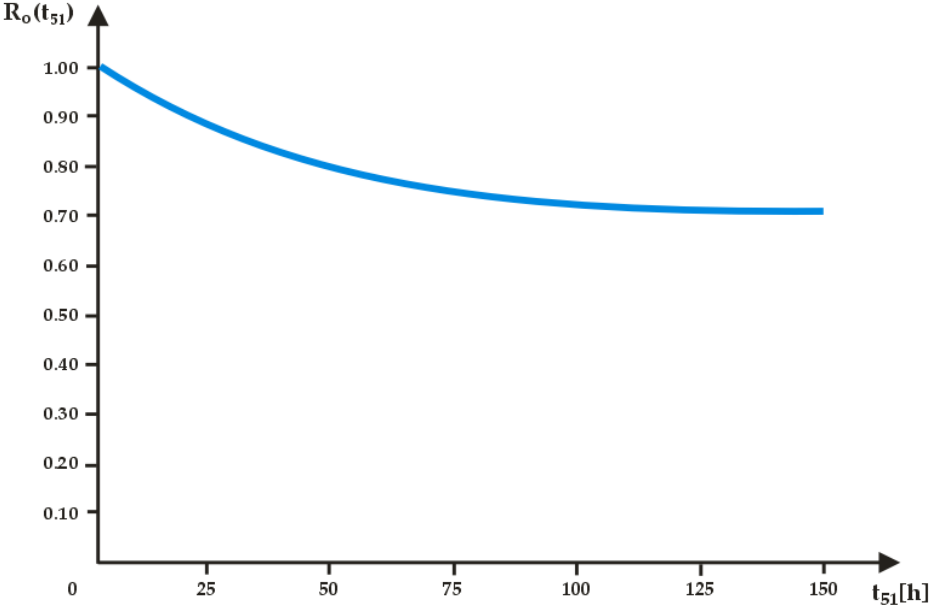
Figure 5. Dependence between the probability of the analyzed WFD system staying in the state of full fitness during the restoration of full system fitness—own study.